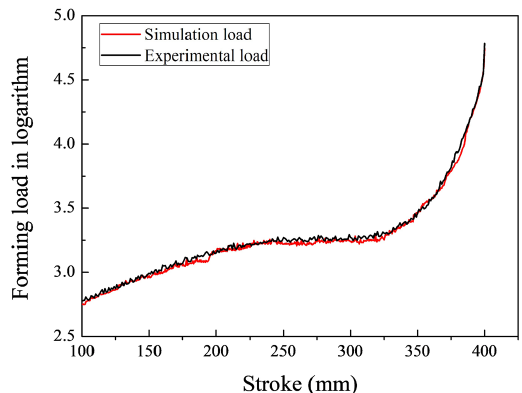
Figure 17. Logarithm load–stroke curves under experimental condition and simulation